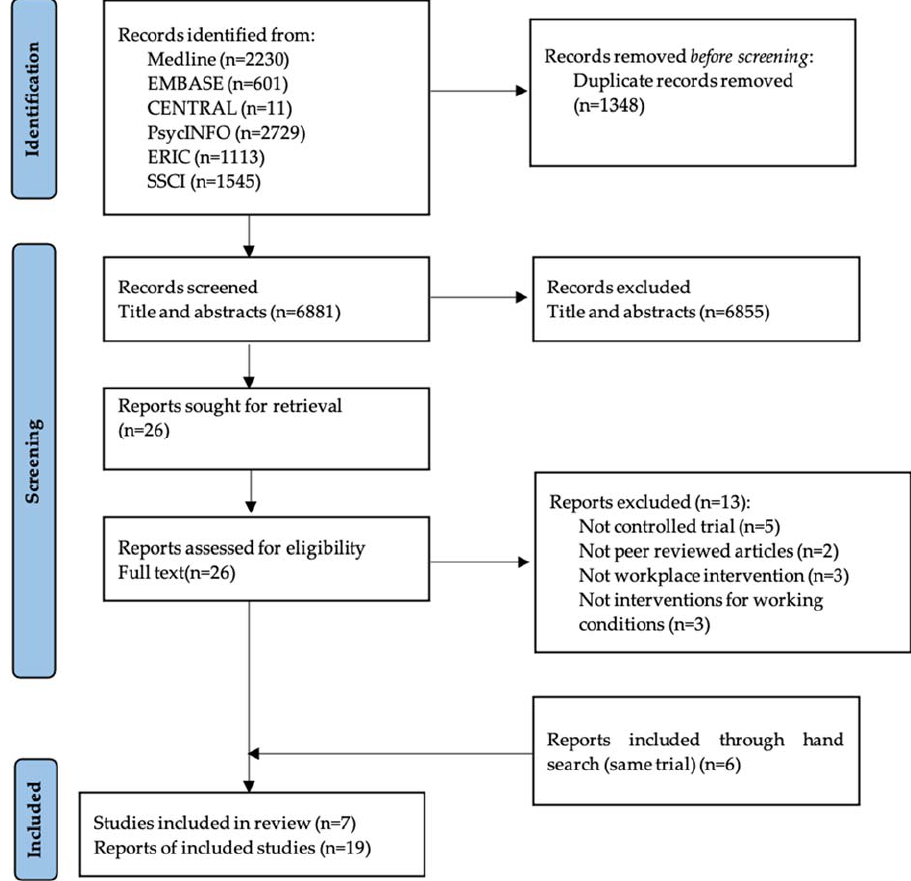
Figure 1. Flow diagram of the study selection process.